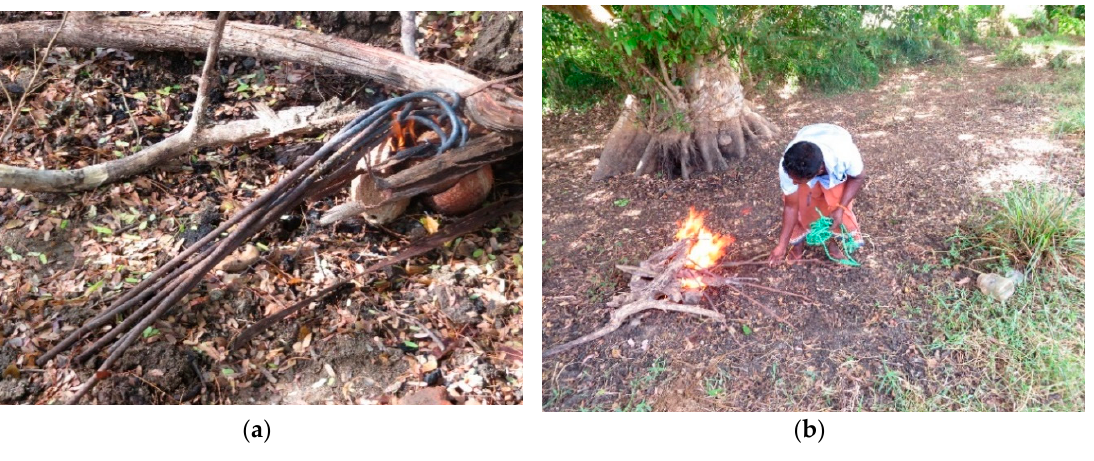
Figure 2. Fire-heated irons used for branding on Farm 1 ( a ) and Farm 4 ( b ).